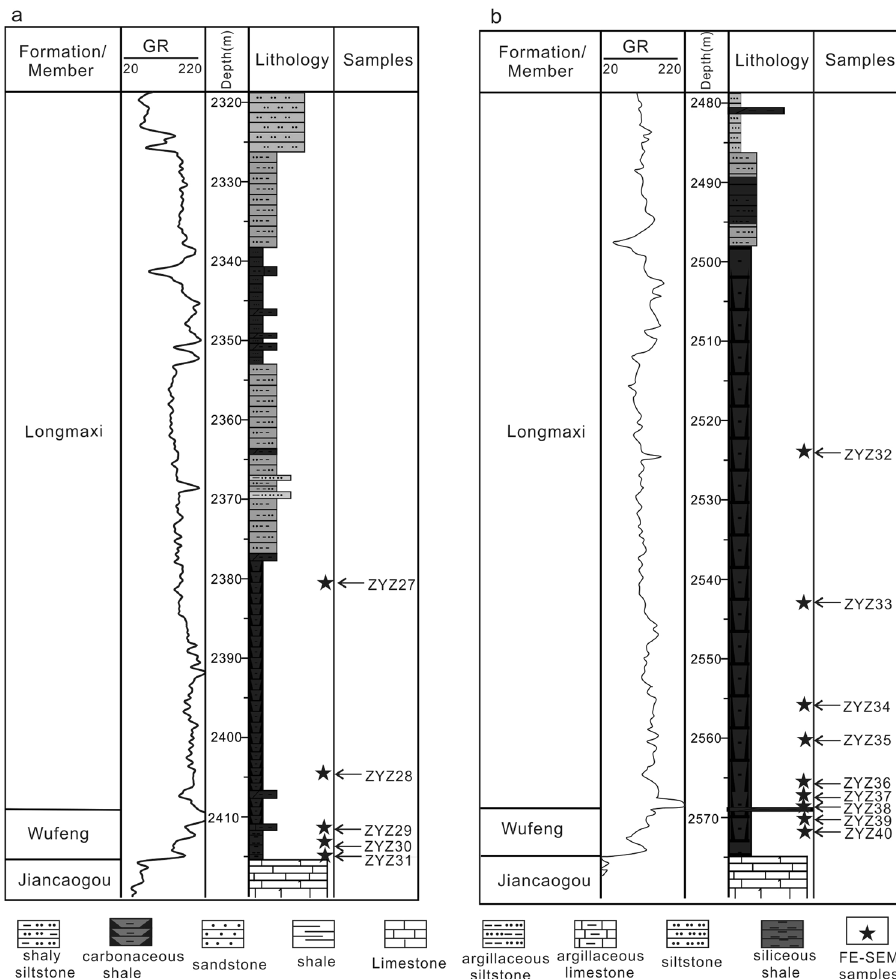
Figure 2. Stratigraphy maps. ( a , b ) a and b displaying the stratigraphy of the Upper Ordovician Wufeng Formation and lower Silurian Longmaxi Formation in wells Jiaoye 1 and Jiaoye 2, respectively; the locations of the two wells are shown in Fig. 1. Depths of the samples used for FE-SEM are also indicated. GR represents the results of the gamma ray (in American Petroleum Institute (API)